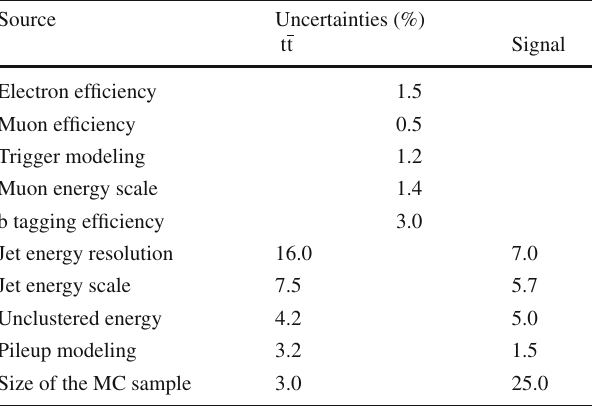
Table 1 Summary of the contributions of the experimental uncertain- ties in the DNN score distribution for signal and the tt background. The values represent the relative variation in the number of expected events across different signal models in the signal